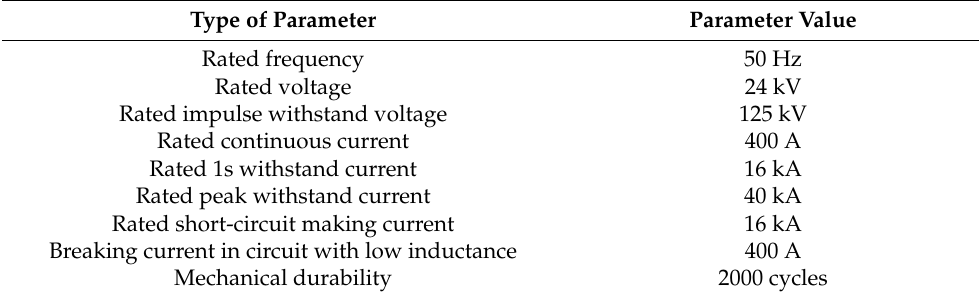
Figure 1. Research object—MV vacuum interrupter of special design: 1—movable contact adapted to mounting the interrupter in a laboratory stand, 2—fixed contact with connection for pumping channel. Table 3. Technical parameters of MV vacuum interrupter used in this study.